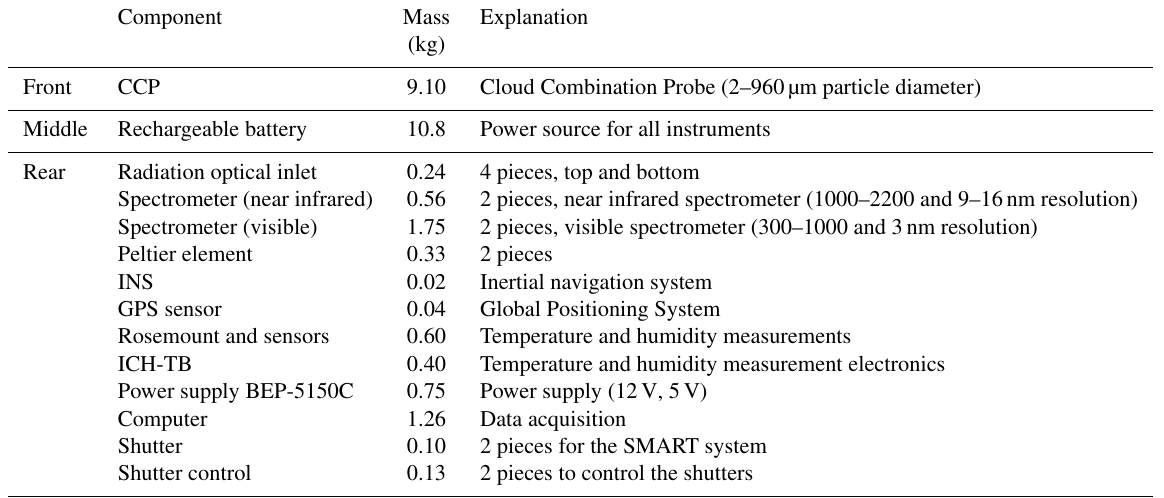
Table 1. Masses of the different instruments and their accessories mounted inside AIRTOSS. Component Mass Explanation (kg) Front CCP 9.10 Cloud Combination Probe (2–960µm particle diameter) Middle Rechargeable battery 10.8 Power source for all instruments 0.24 4 pieces, top and bottom